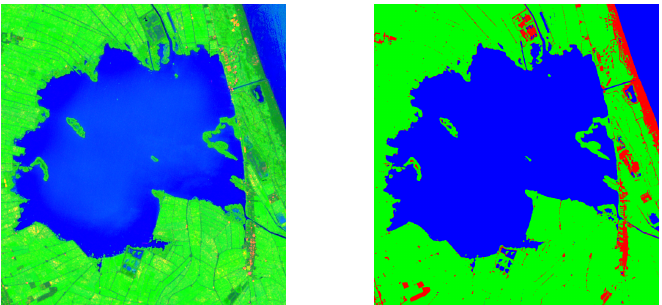
Figure 1. The false RGB colour of the lake under investigation (R: VH polarisation, G: NDVI, B: MNDWI), on the left, and the segmentation maps (R: Bare soil, G: Vegetation, B: Water), on the right. The latitude and the longitude of the images go from N 39.372 to N 39.288, and from W 0.304, respectively. Both in a specific date: 24 August 2019. −